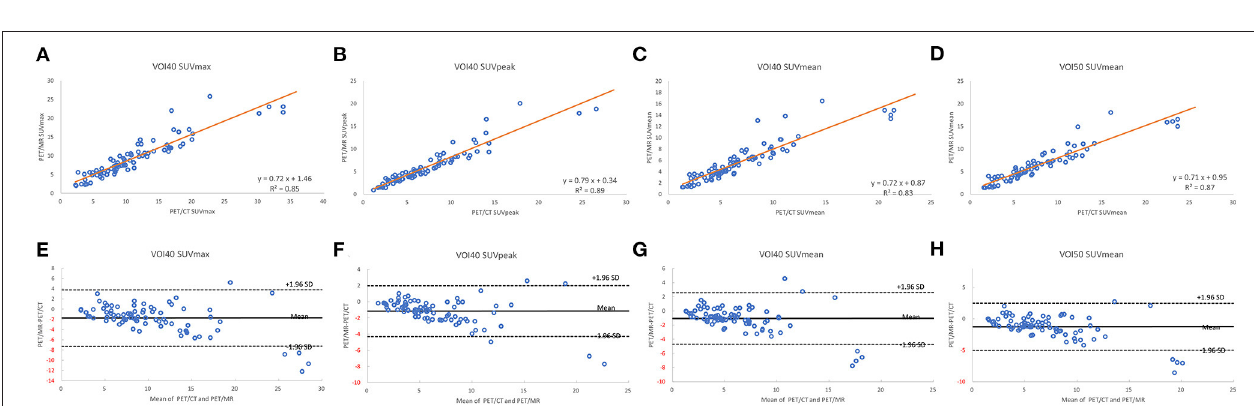
FIGURE 2 | Scatter diagram with regression line and Bland-Altman plots of PET-CT and PET-MR for SUVmax (A,E) , SUVpeak (B,F) , and SUVmean (C,G) of VOI40 and SUVmean of VOI50 (D,H) .